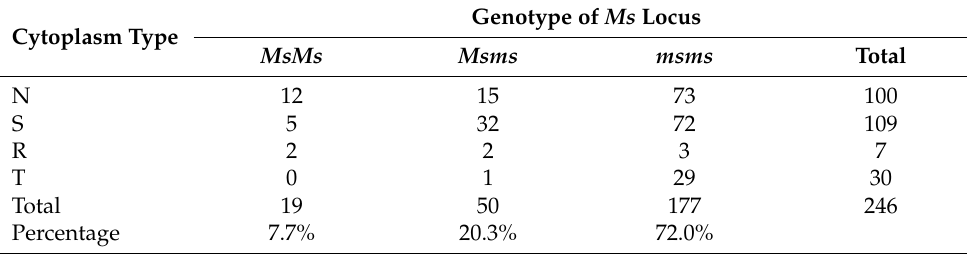
Table 3. Cytoplasm types and genotype of Ms locus in the onion breeding lines. Cytoplasm